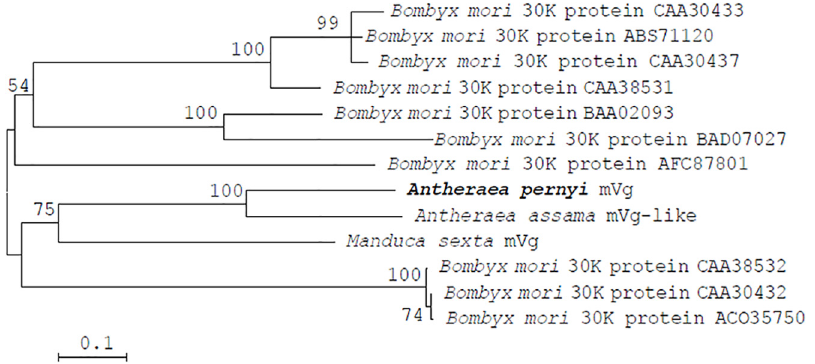
Fig 2. Phylogenetic tree based on amino acid sequence comparisons. The numbers near the branch represent bootstrap percentages. The topology was tested using bootstrap analyses (1,000 replicates). The GenBank accession number is shown following the organism